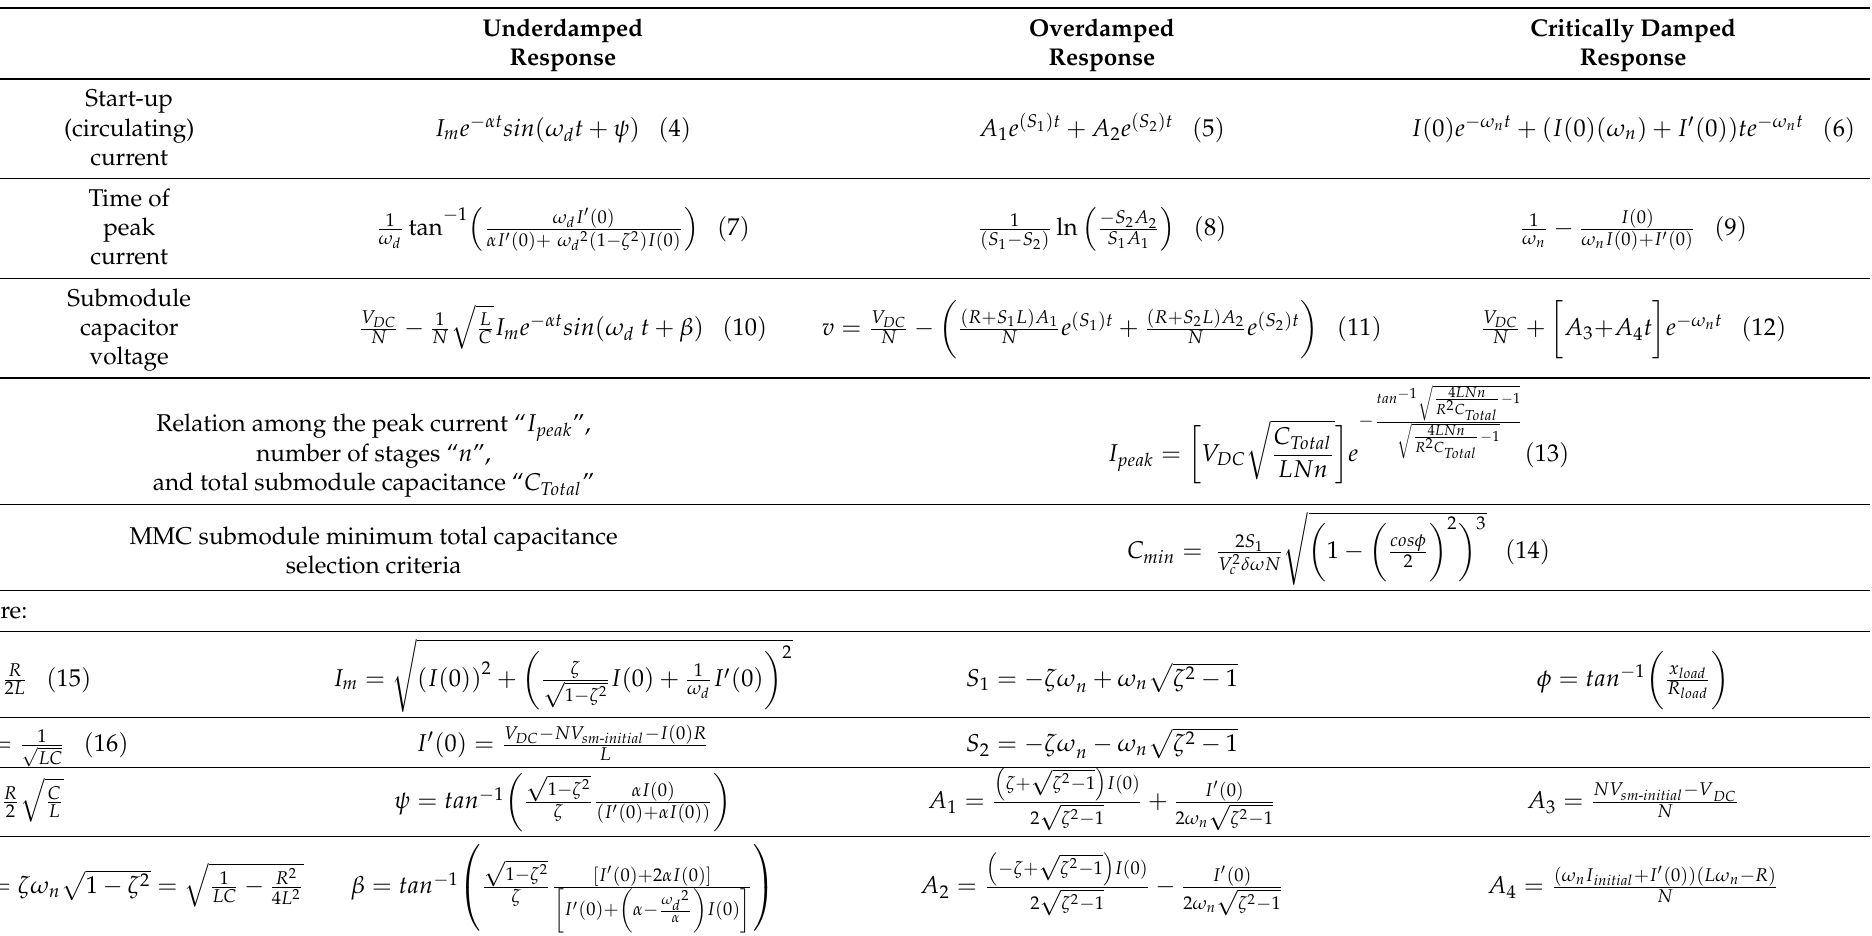
Table 1. Summary of the equations used in the proposed start-up method